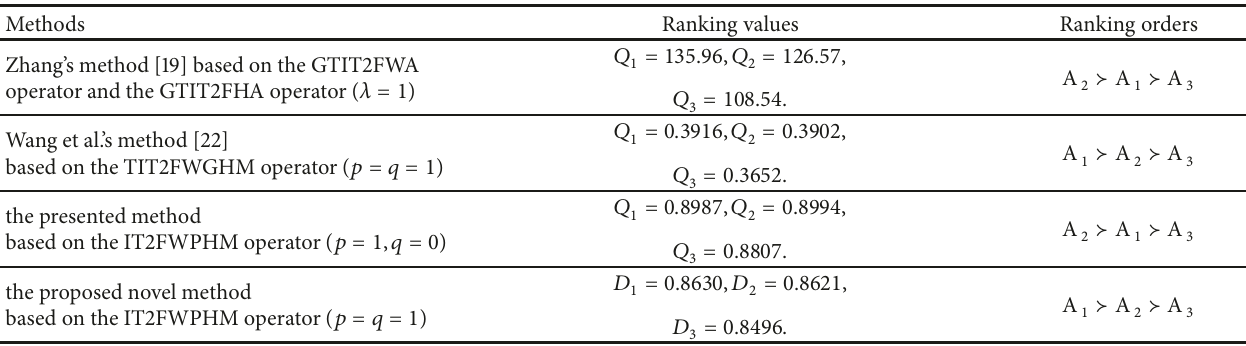
Table 9: Rankings of the different methods for Example